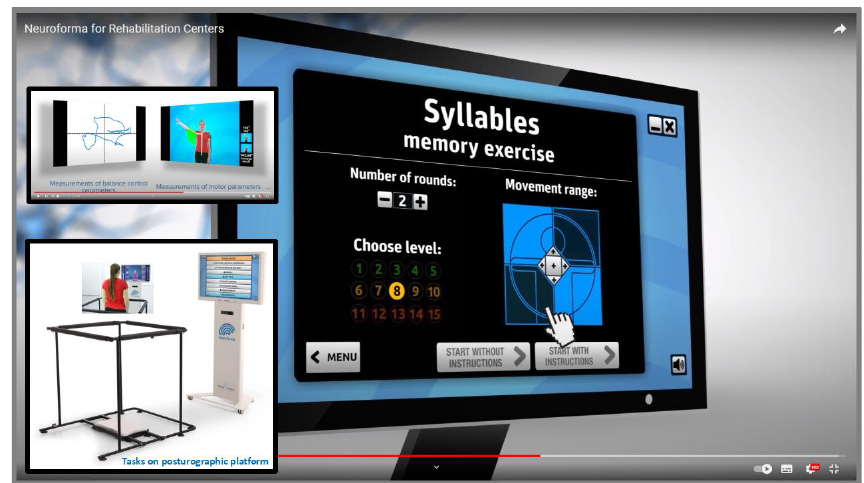
Figure 2. The view of the menu of the Syllables exercise parameters, regarding the selection of the number of rounds, level of difficulty, and range of movement in the VR NEUROFORMA system, and also the view of its version with the posturography platform and safety barriers (materials from our lab repository, with permission of Titanis Ltd.).